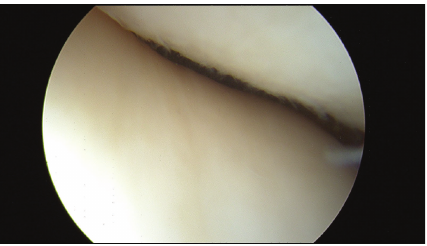
Figure 5: Image from arthroscopy demonstrating no osteochondral damage to the patellofemoral region.